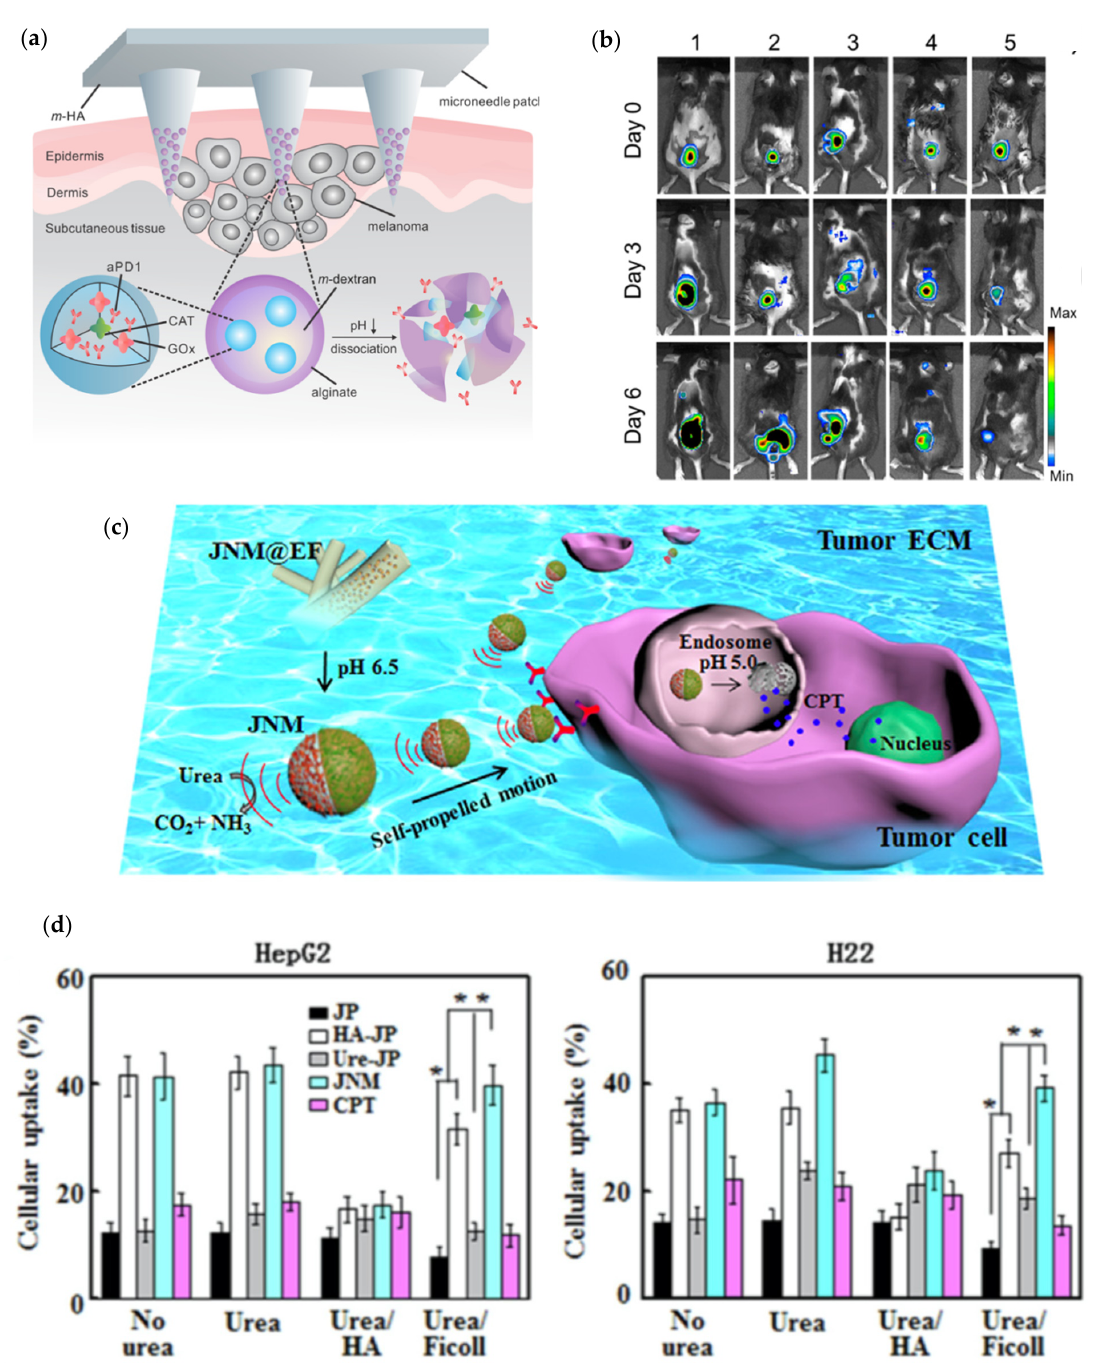
Figure 4. ( a ) Design schematic of degradable HA microneedle patch for the site-specific delivery of anti-cancer drugs to melanoma cells. Reprinted with permission from ref. [15]. 2016 American Chemical Society. ( b ) Tumor observation via bioluminescence imaging on day zero, day three, and day six of the experimental treatment trial performed by Wang et al., with treatments 1-5 discerning melanoma untreated and treated with MN-GOx, free aPD1, MN-aPD1, and MN-GOx-aPD1, respec- tively. Reprinted with permission from ref. [15]. 2016 American Chemical Society. ( c ) Schematic representation of the movement of designed nanomotors through the ECM of a tumor before intra- cellular dissolution for the release of cytotoxic CPT as a mean of cancer therapy. Reprinted with permission from ref. [16]. 2019 Elsevier. ( d ) HepG2 and H22 cellular uptake percentages for JPs, HA- JPs, urease-JPs, JNMs, and free CPT, respectively, in media without urea, urea alone, urea with HA, or urea with Ficoll (* signifies p < 0.05). Reprinted with permission from ref. [16]. 2019 Elsevier. Following a month of storage, the bioactivity of the MN patch system was maintained at 90%. The gradual release of aPD1 occurred over the course of three days. Increased T-cell infiltration was also observed in patch-treated tumors when compared to the control group, and most importantly, mice treated with the fully developed patch saw an increase in anti- tumor activity relative to mice treated with free aPD1, while tumor growth was significantly inhibited in mice treated with MN-GOx , free aPD1, MN-aPD1, and MN-GOx-aPD1, re- spectively(Figure 4b). Furthermore, there was no significant inflammation observed; mice saw increased lifespans, with 40% survival after 40 days following aPD1-GOx-MN treat- ment and about 70% of T-cell promoting anti-CTLA4 antibody and aPDI treated mice be- ing cancer-free beyond 60 days when the MN patch was used. The slow and sustained release over three days for the HA-based MN complex, in contrast to the diffusion away from the tumor sight observed following three days for free aPD1, leant a low cost of ad- ministration for such therapy with only one administration being necessary to produce the desired immune responses within the cancerous mice tested [15].